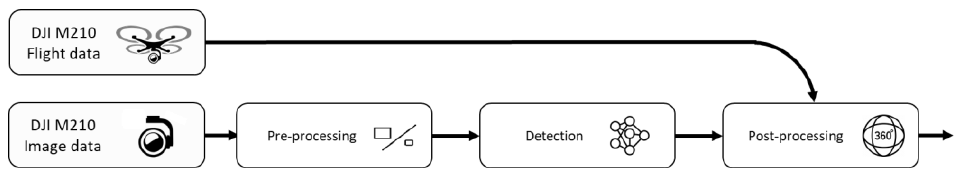
Figure 25. Drone vision algorithm diagram.